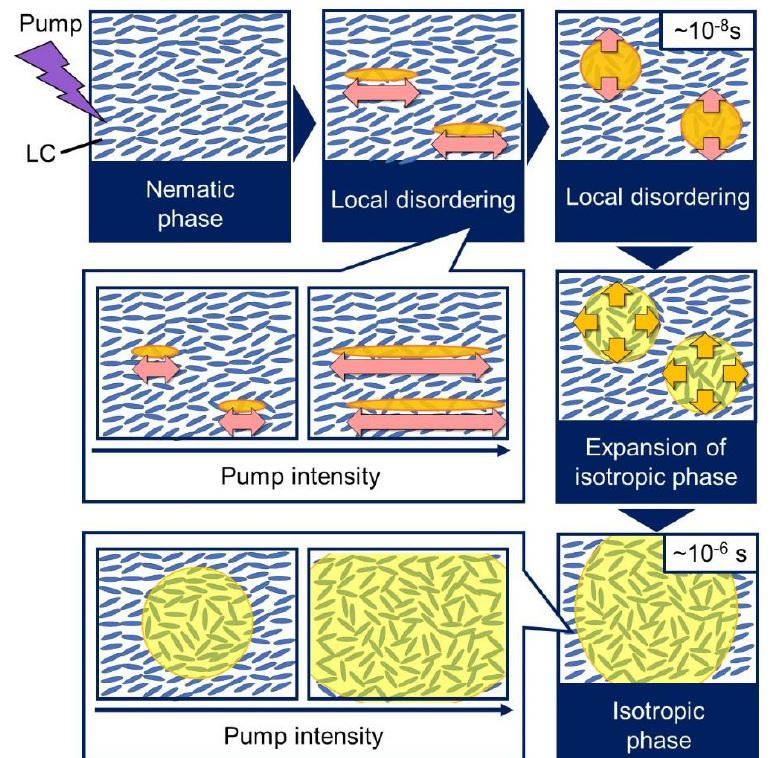
Figure 6. The schematic illustration of the photo-induced phase transition model is summarized.